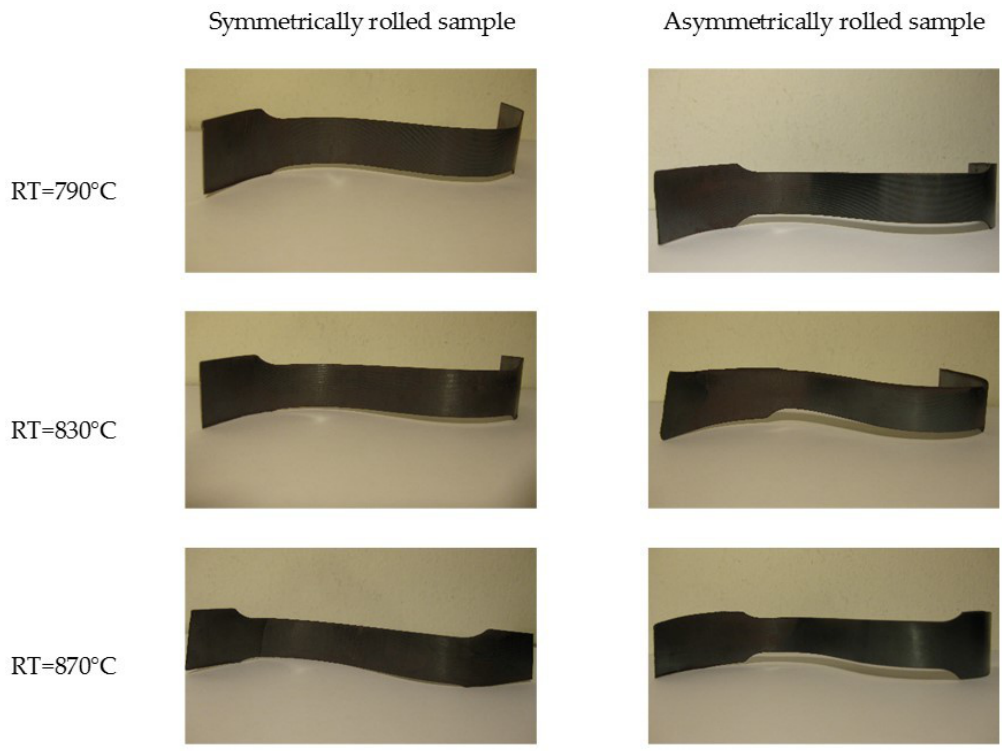
Figure 10. The flat surfaces of the strips bent under different thermomechanical conditions with no fluting segments in the high-boron low-carbon steel.